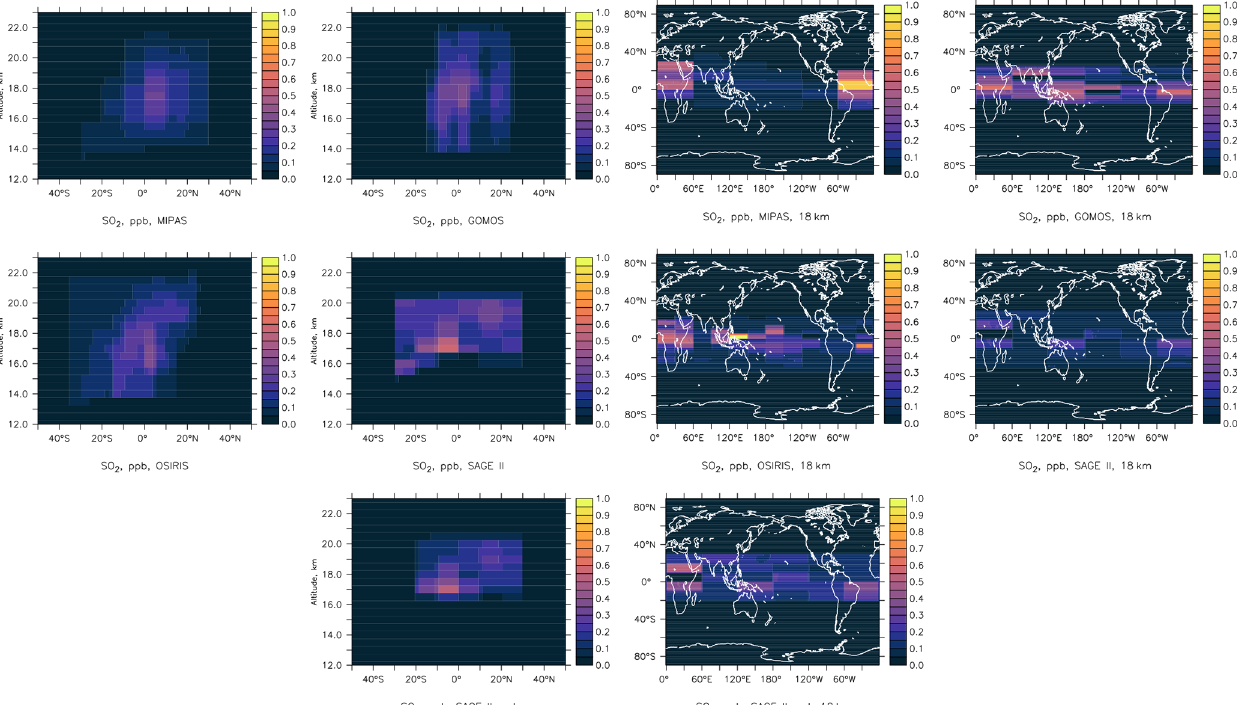
Figure B1. 2002 Reventador eruption: SO 2 mixing ratio perturbation (ppb) derived from MIPAS and the three extinction instruments. MIPAS data of 7 to 17 November 2002, OSIRIS and GOMOS data of 11 to 22 November, and SAGE II orbits of November and early December 2002. Zonal average vertical distribution (left) and plumes at 18km altitude (right). OSIRIS with a correction factor of 0.8 due to remnants from the Ruang eruption and SAGE II with the Grainger-based method. Lower row: SAGE II SO 2 derived from extinction (interpolated to 750nm from 525 and 1020nm). Factor 1 is the default.